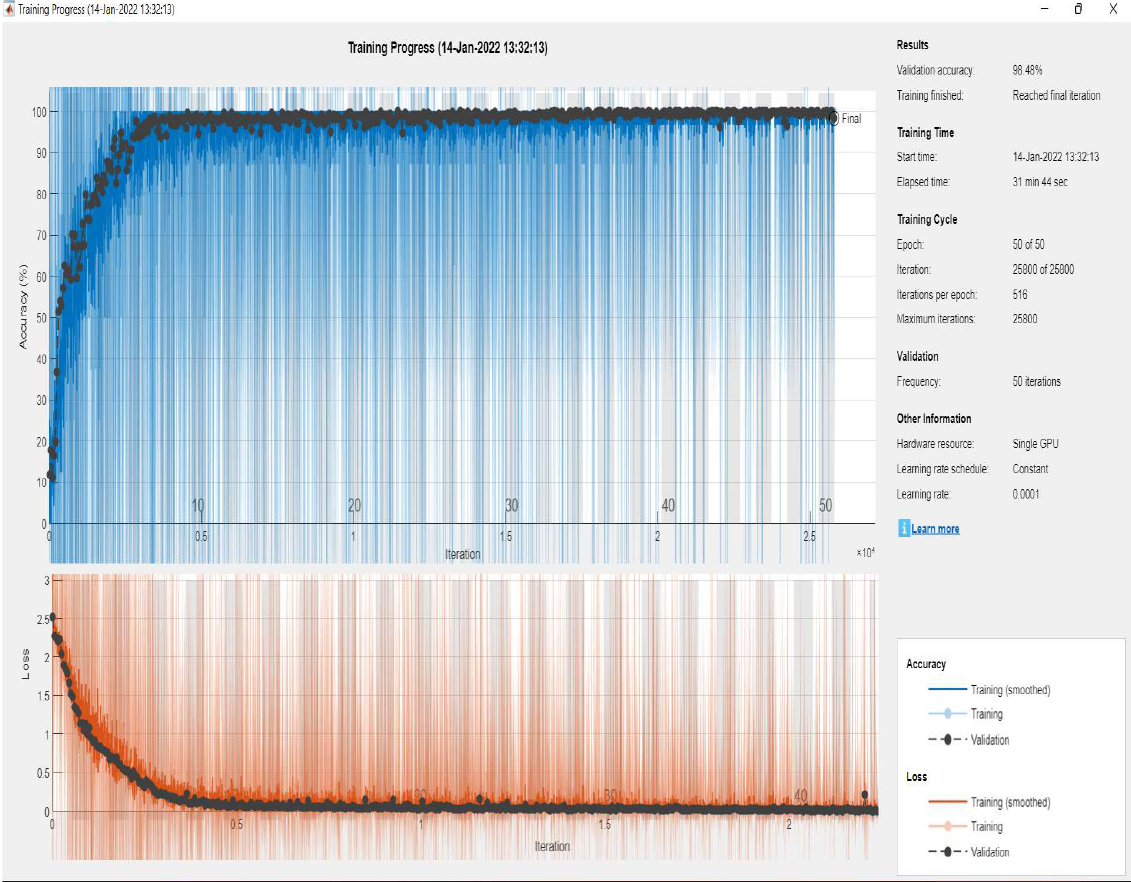
Figure 19. Accuracy and loss rate of SE for noisy LFM by CNN.